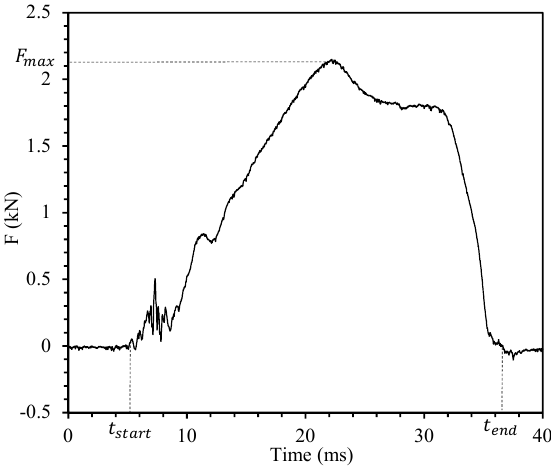
Fig. 4 The data extracted from a common force against time